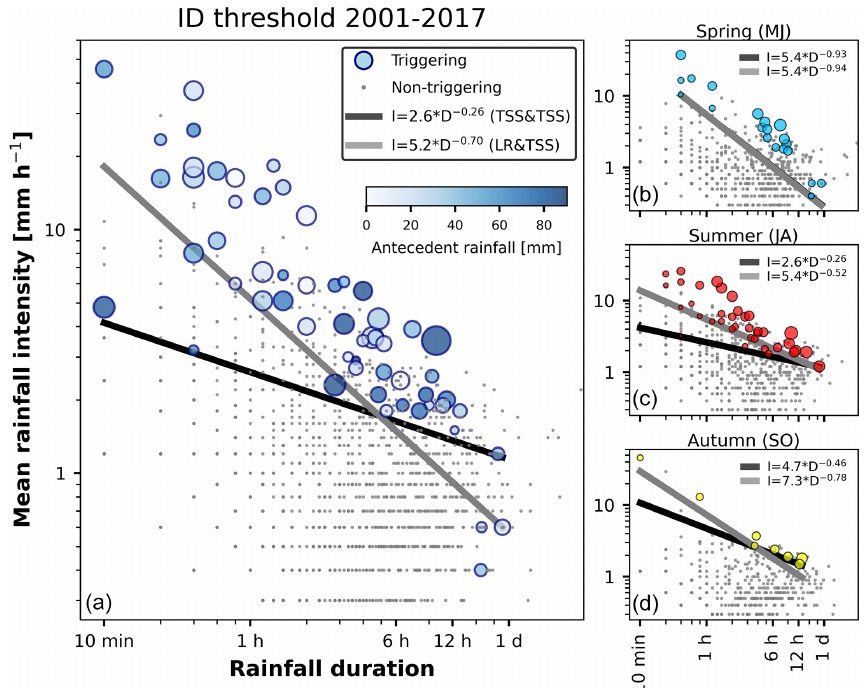
Figure 4. ID thresholds for the Illgraben catchment computed with two methods. (a) ID thresholds for the entire data set. For the 67 triggering events, the 14d antecedent rainfall (blue colour) and the (relative) bulk volume (marker size) of the debris flows are also shown. (b–d) ID thresholds for each season, where the lines are the thresholds computed using TSS&TSS (black) and LR&TSS (grey). The marker size indicates the total event rainfall.